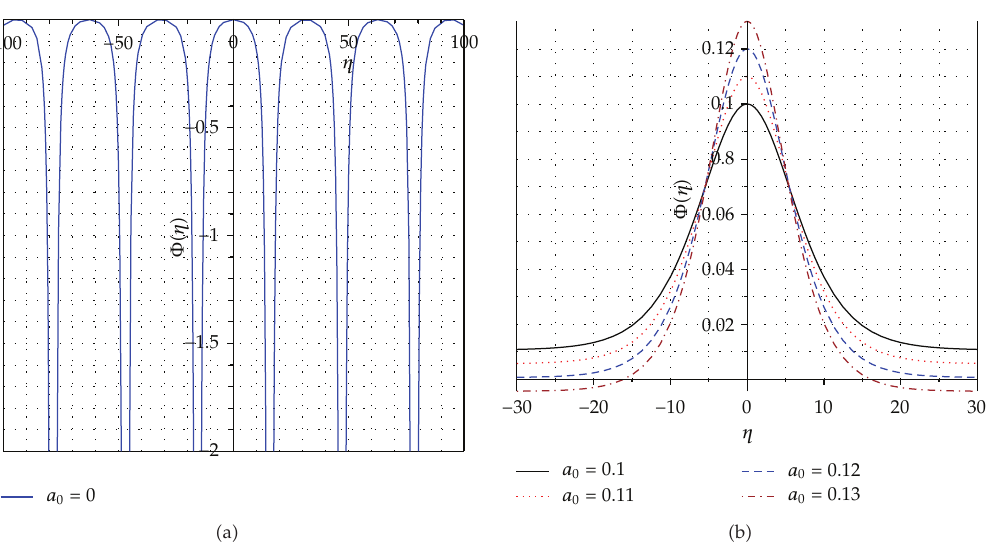
Figure 2: Profile of pulses for expression (cid:2) 4.5 (cid:3) for v (cid:7) 0 . 04, σ (cid:7) 0 . 001, and γ 0 (cid:7) 0 . 01.